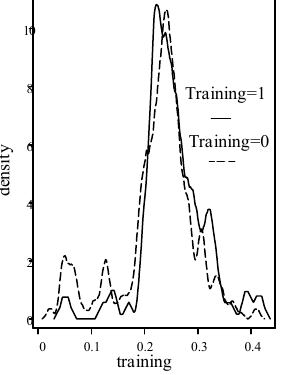
Figure 3. Overlapping test of participating in training.